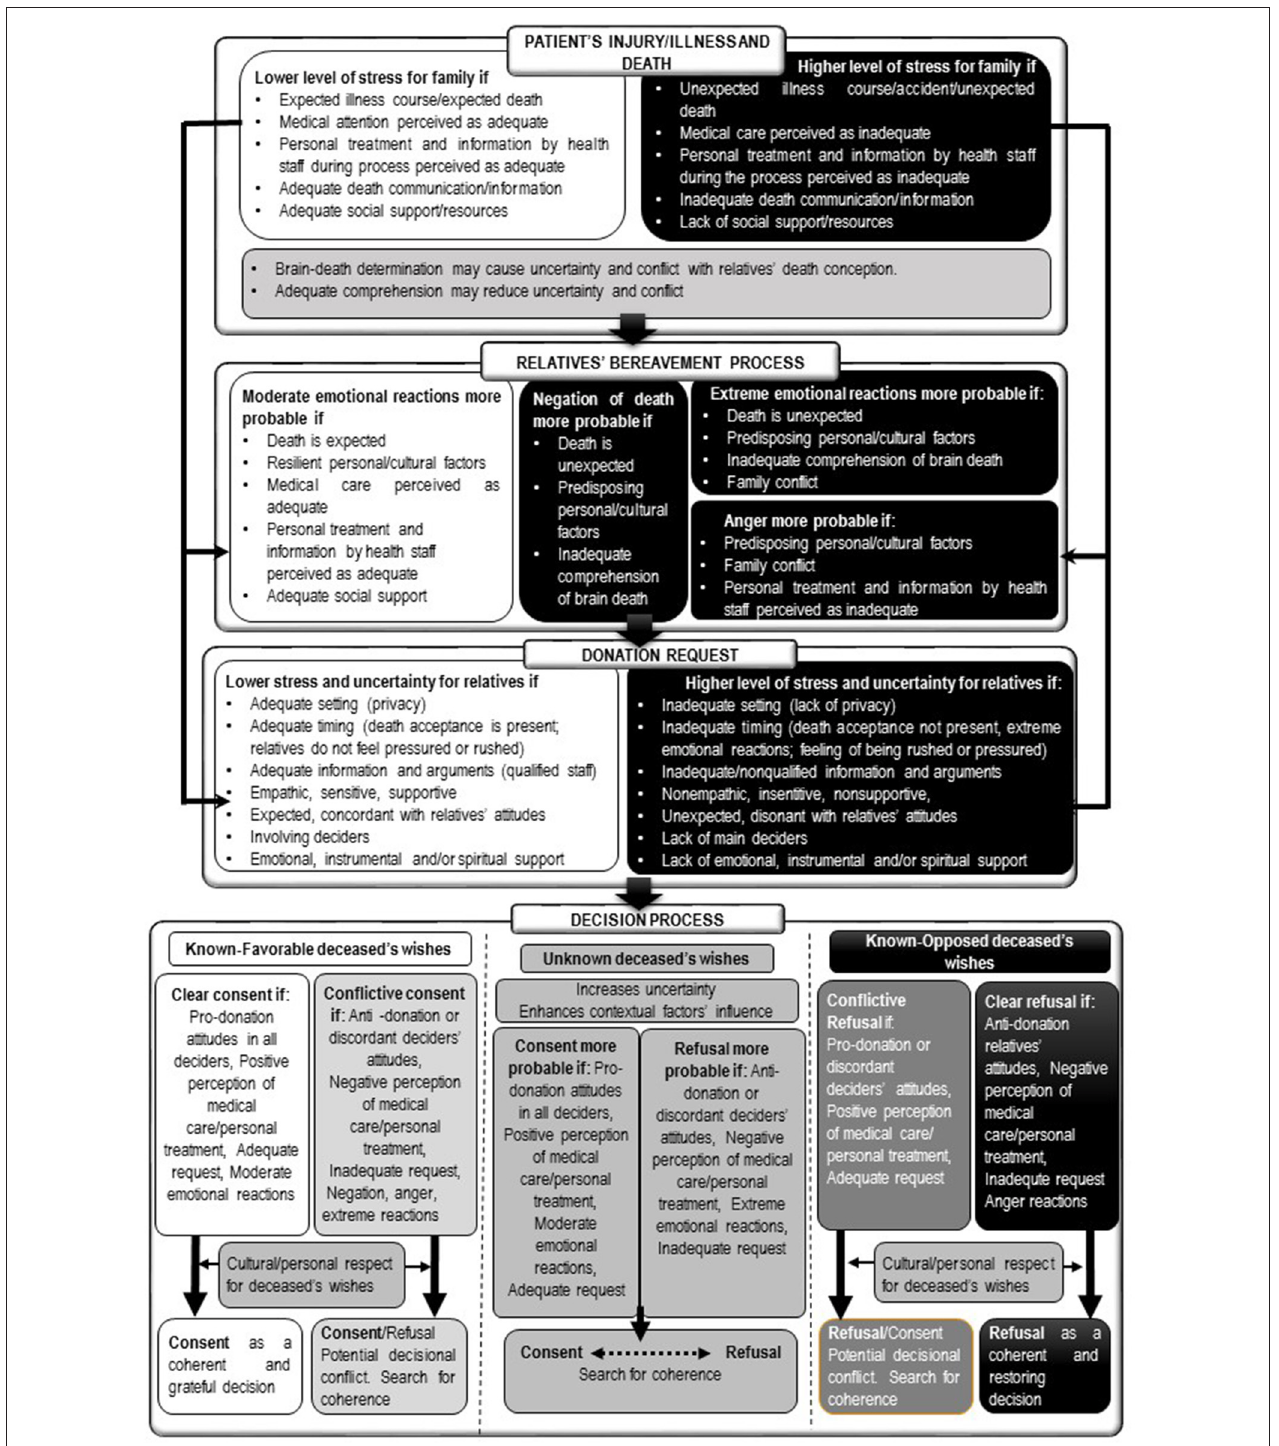
FIGURE 3 | Processual view of family experience and family